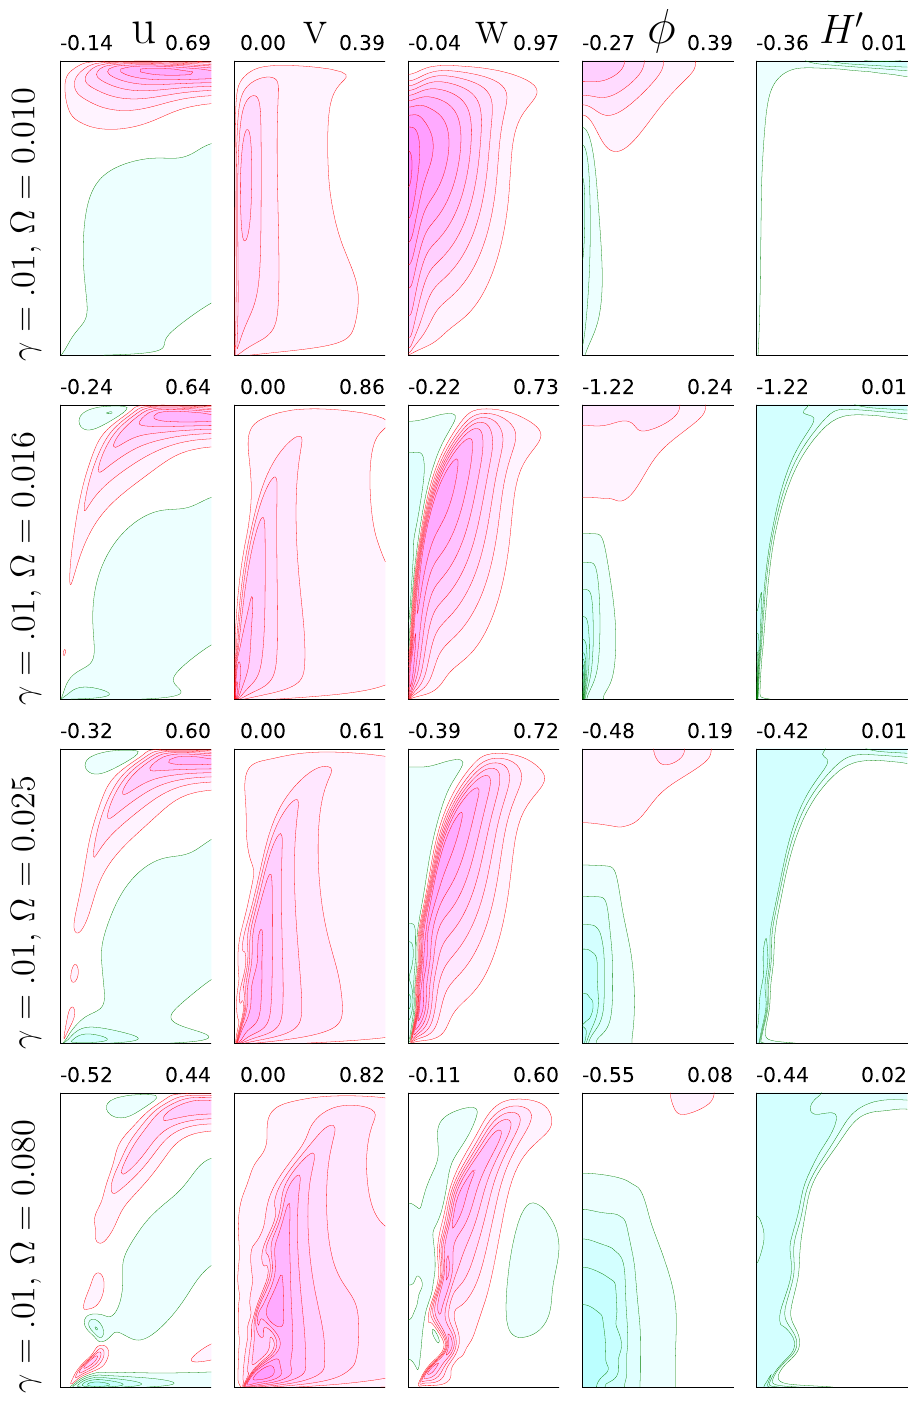
Figure 4. Simulations with γ = 0.01 at t =